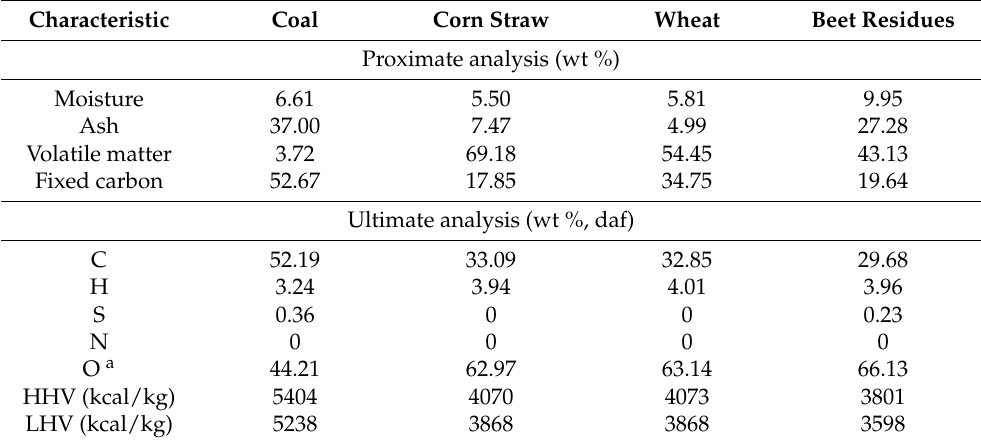
Table 1. Proximate analysis, ultimate analysis, and thermal properties of the unblended samples.